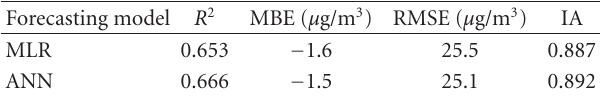
Table 3: Performance statistics for the validation of the developed